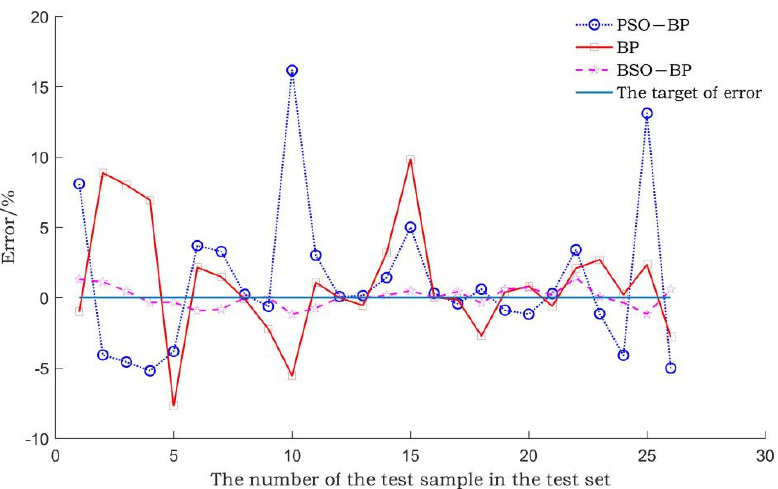
Figure 7. Comparison of gross weight prediction errors of different models.